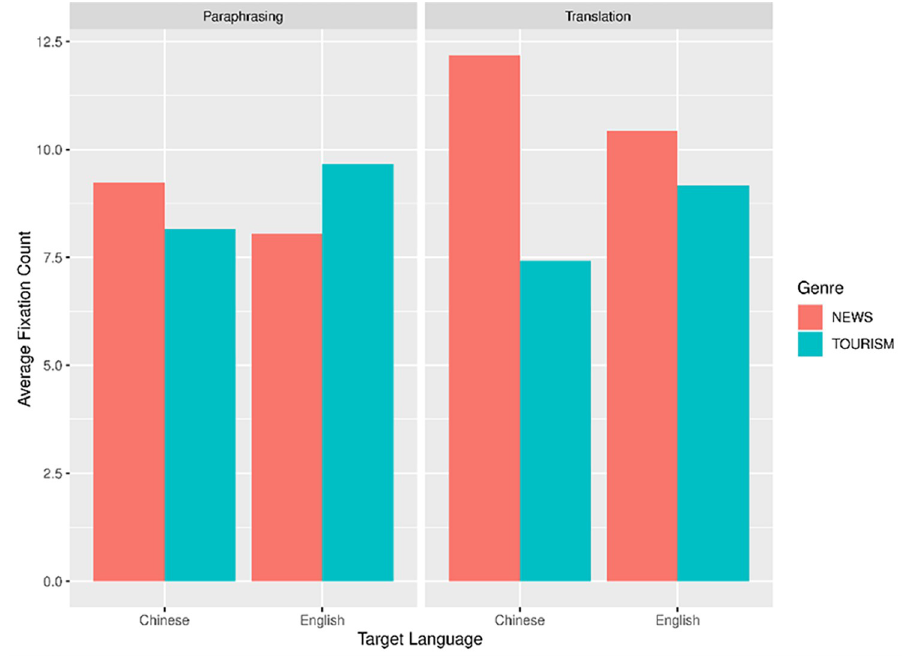
Fig 5. Average fixation count in